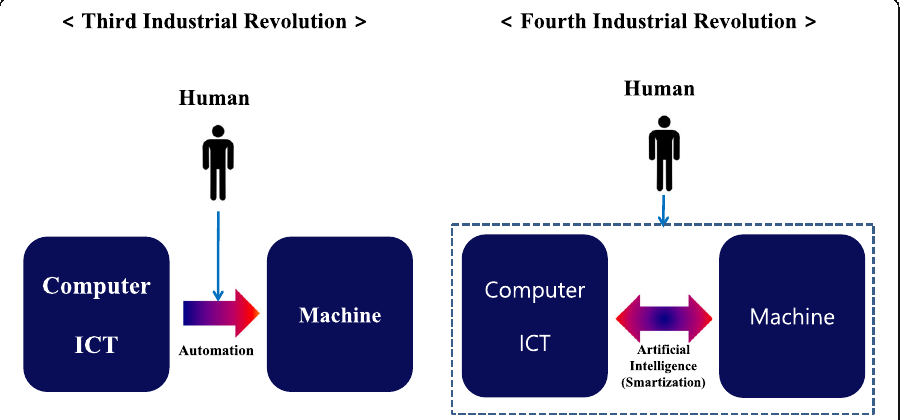
Fig. 1 Comparison of the Third and Fourth Industrial